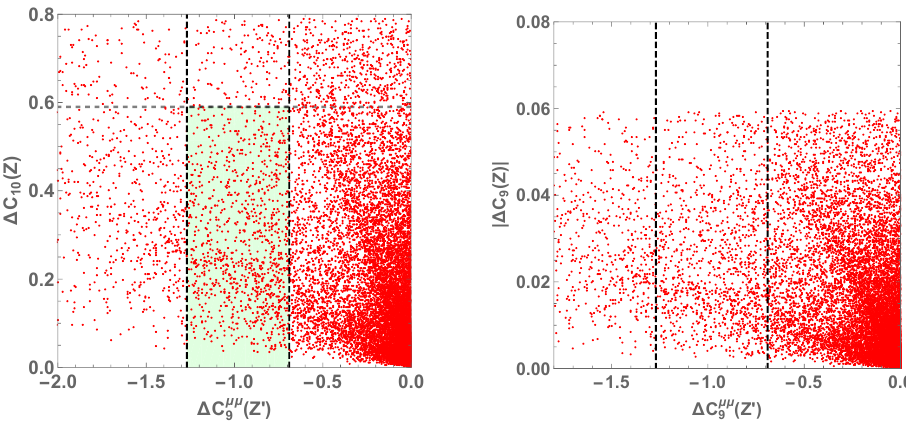
Figure 3 . Left: scattering plot on { ∆ C µµ nomenological constraints except for ∆ C 9 , 10 . Right the same plot on { ∆ C µµ